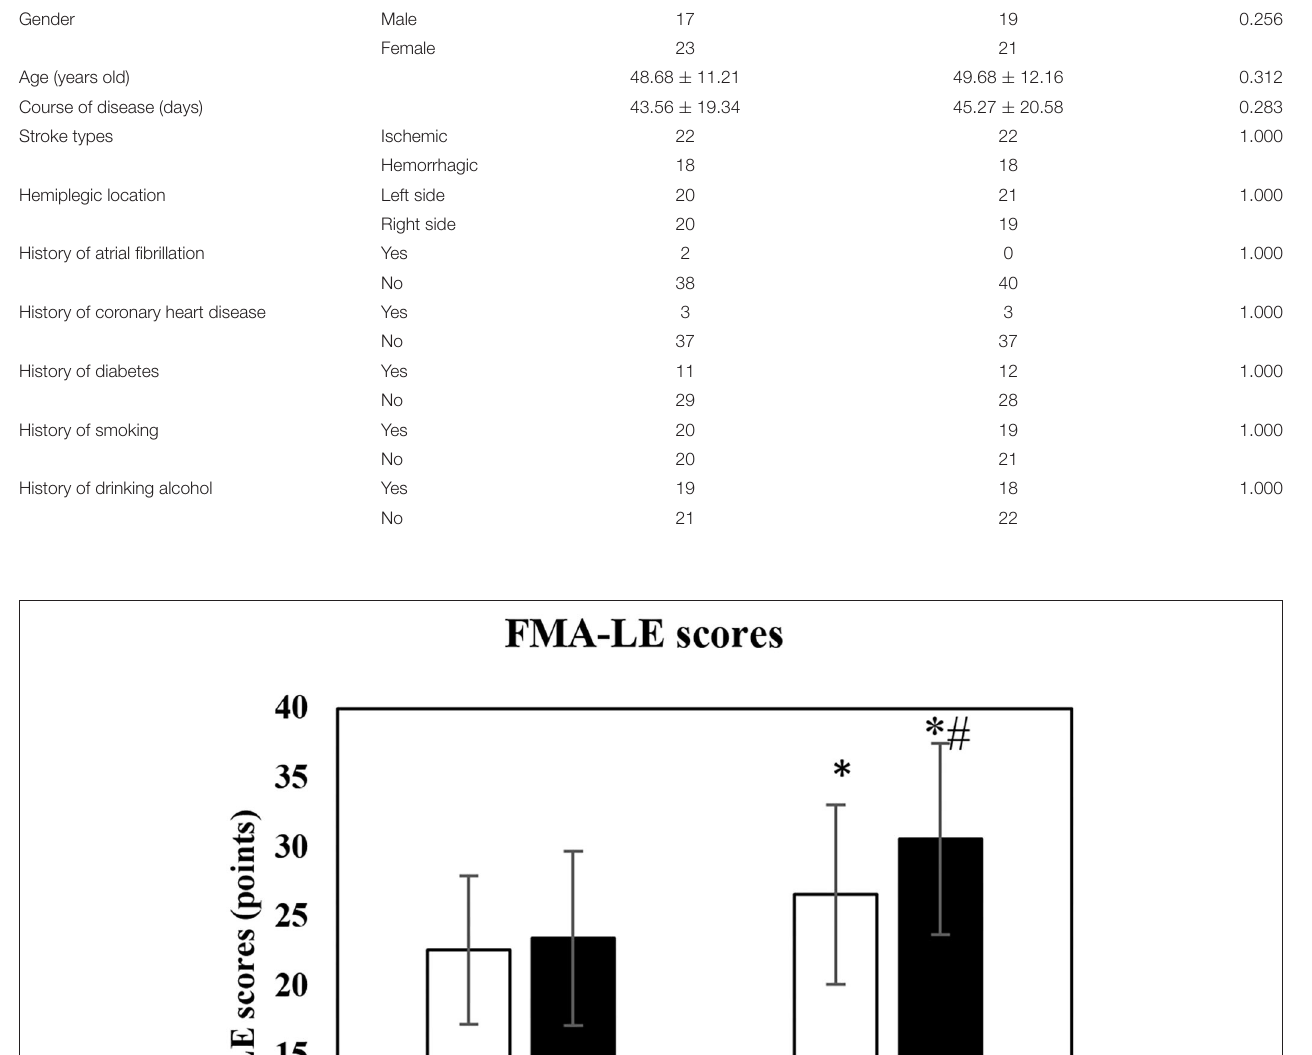
Frontiers in Neurorobotics |